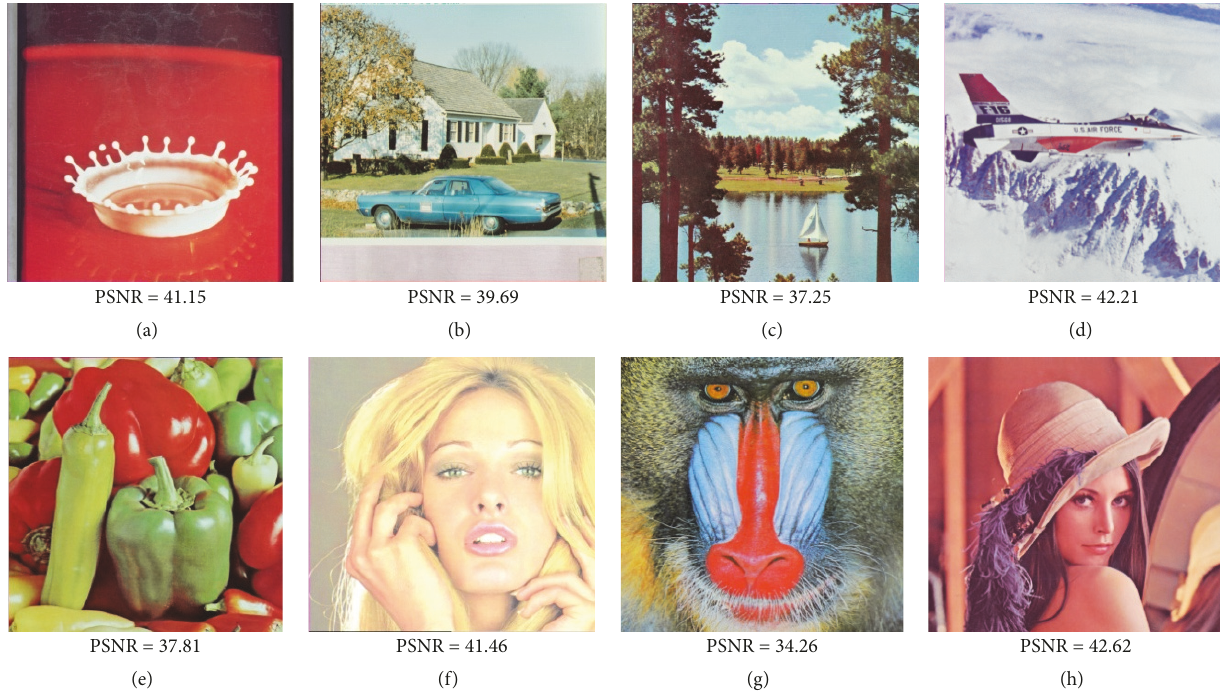
Figure 5: Stego images of proposed type 1 (t=3, range table 1).